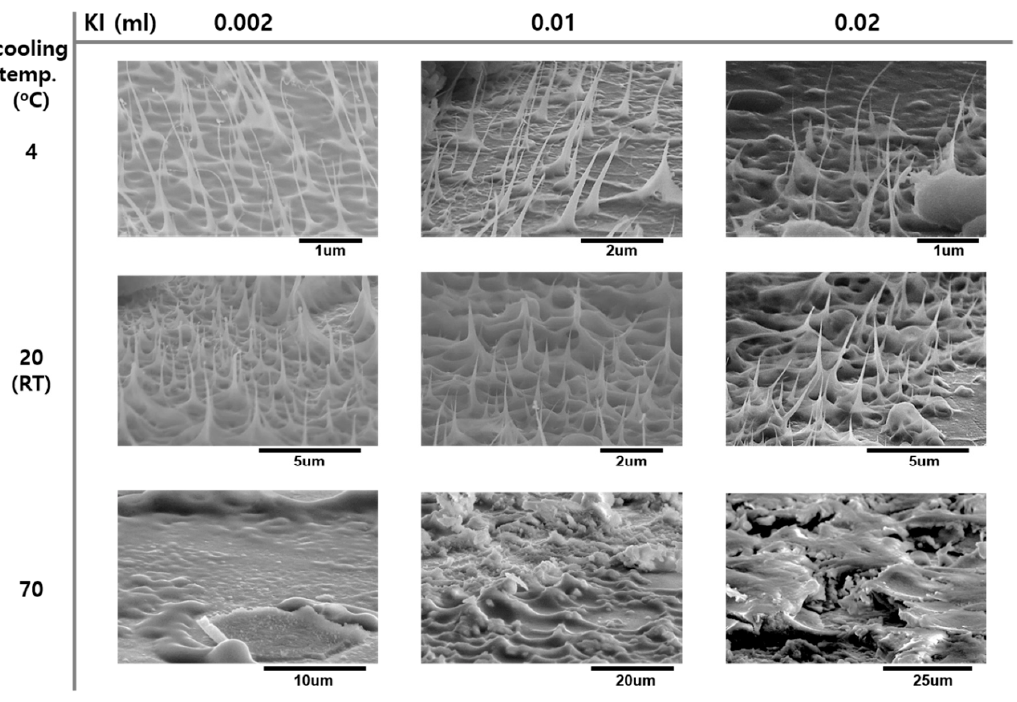
Figure 5. SEM images of a -Si nanotips formed on a Si substrate as functions of KI concentration and cooling temperatures.